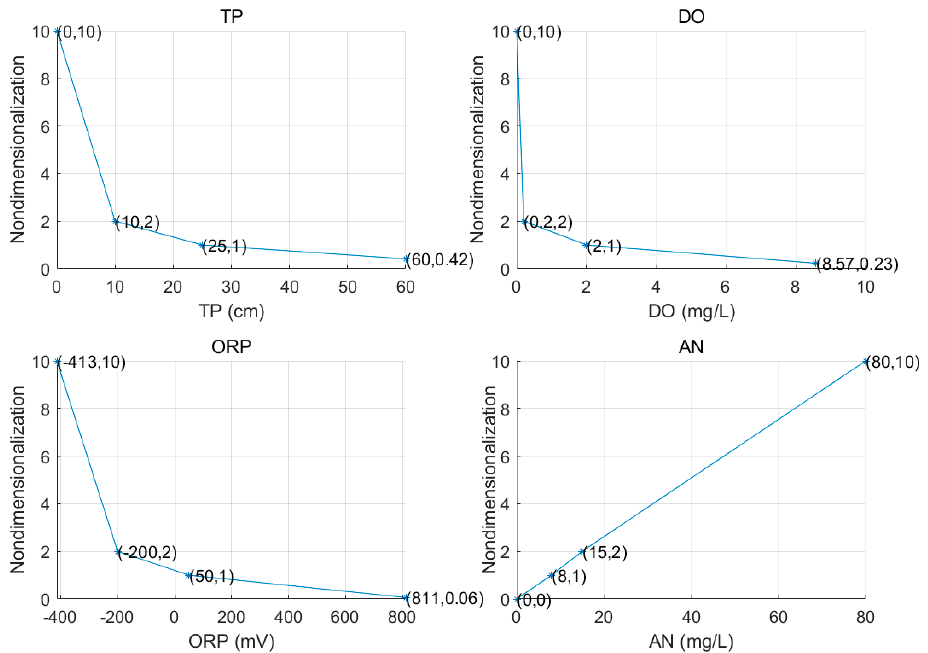
Figure 6. Dimensionless functions of Secchi depth (SD), dissolved oxygen (DO), oxidation-reduction potential (ORP), and ammonia nitrogen (AN).